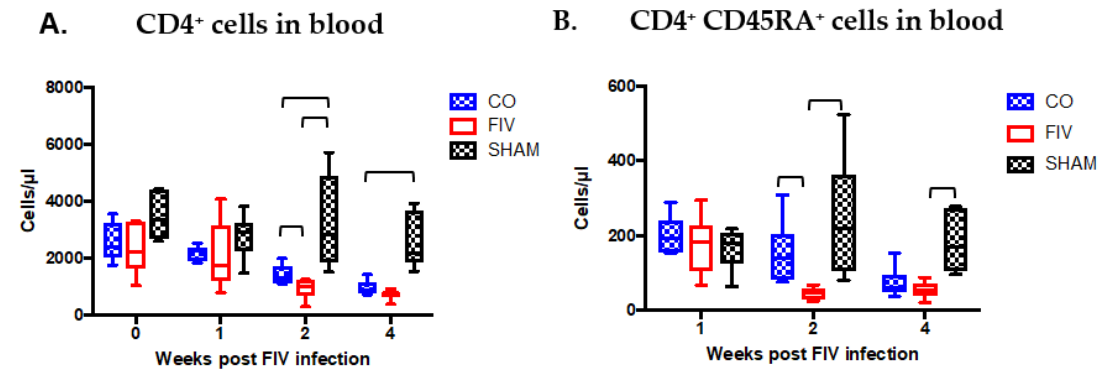
Figure 3. CD4 + cells were preserved in the blood of CO as compared with FIV cats at 2 weeks ( P = 0.0492), and approached preservation at 4 weeks ( P = 0.0612) FIV PI. At 2 and 4 weeks FIV PI, control SHAM cats had higher CD4 + cells than FIV cats ( P = 0.002 and P < 0.0001, respectively), and CO cats (2 weeks, P = 0.0090; 4 weeks, P = 0.0034) ( A ). Naïve CD4 + CD45RA + cells were also preserved in the CO cats compared with FIV cats at 2 weeks ( P = 0.0012), but not at 4 weeks ( P = 0.332) FIV PI. At 2 and 4 weeks FIV PI, SHAM CD4 + CD45RA + cells were greater than FIV cats (2 weeks, P = 0.0069; 4 weeks, P = 0.0012), yet the SHAM was only different than the CO cats at 4 weeks FIV-PI ( P = 0.0062) CD4 + cells ( B ). Bars indicate statistical differences between the indicated groups. Significant differences were noted among the three groups over time (CD4 + cells, P = 0.0004; CD4 + CD45RA + cells, P = 0.0012).